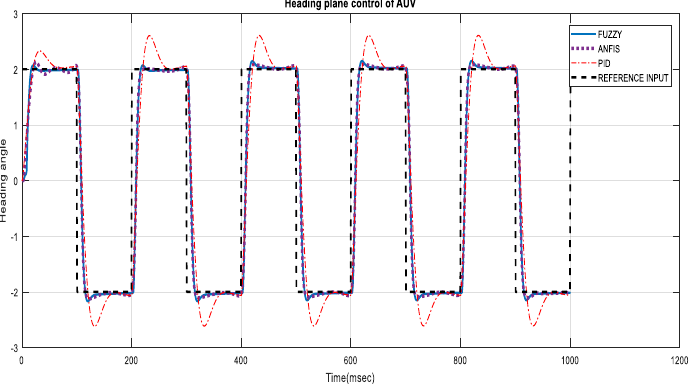
Figure 22. Square wave response of heading plane control.